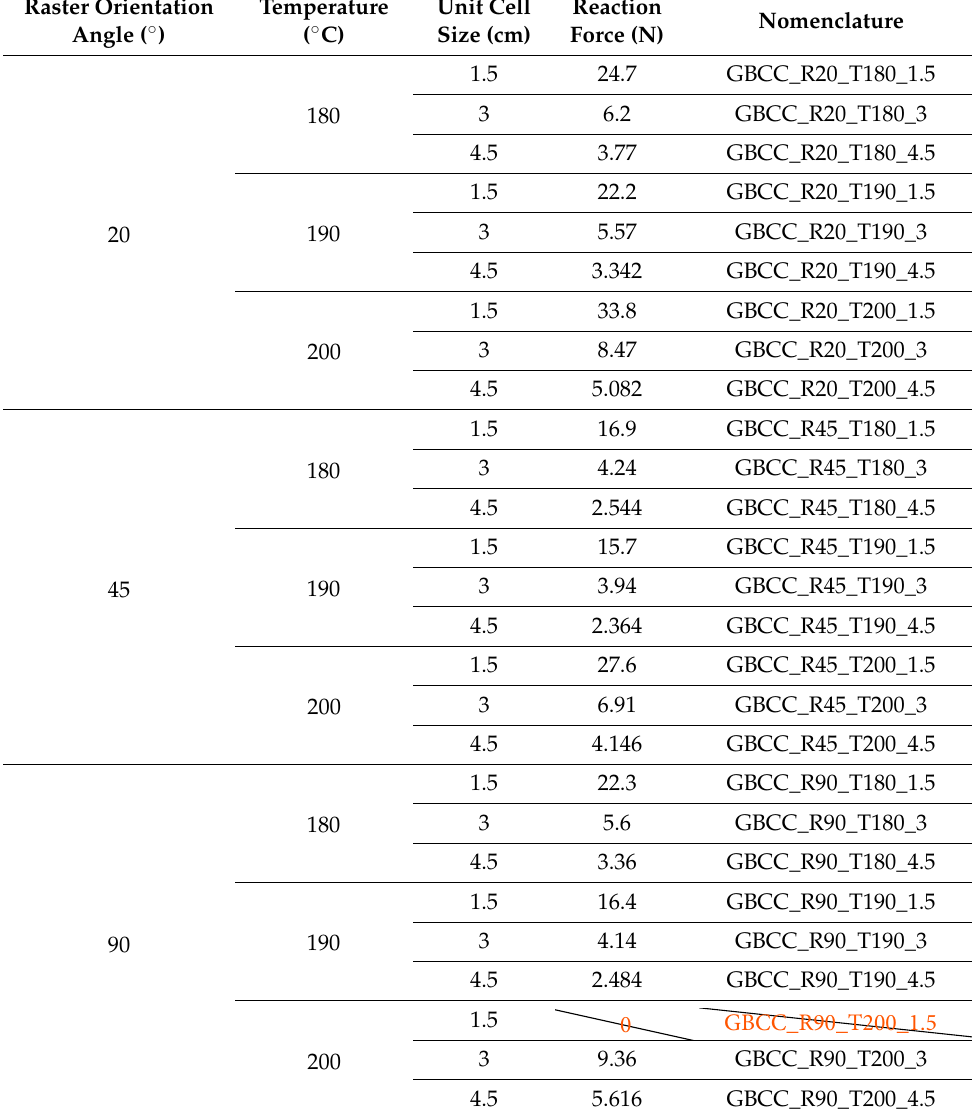
Table A1. Results obtained for BCC. Table A2. Results obtained for BCCz.